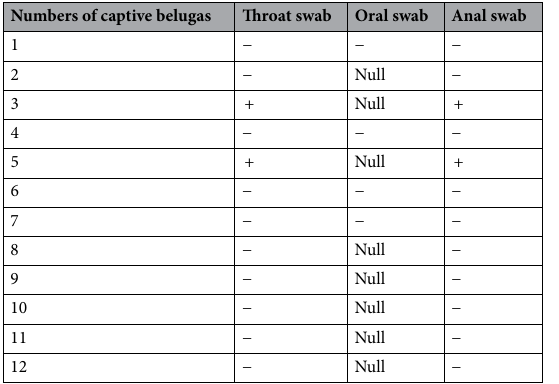
Table 1. Prevalence of PicoV-HMU-1 in samples of captive belugas from Qingdao Polar Haichang Ocean Park. Samples found to be positive or negative by nested-PCR are indicated by + or – signs, respectively. Null indicates that the sample was not collected.